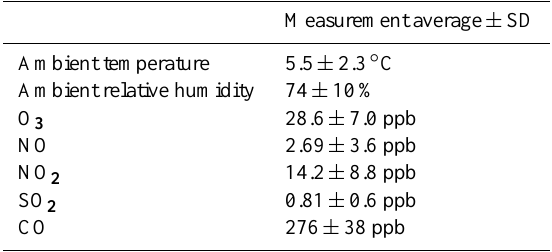
Table 1. Ambient temperature, relative humidity and the concen- trations of gases during the field measurements at SMEAR III (SD: standard deviation, ppb: parts per